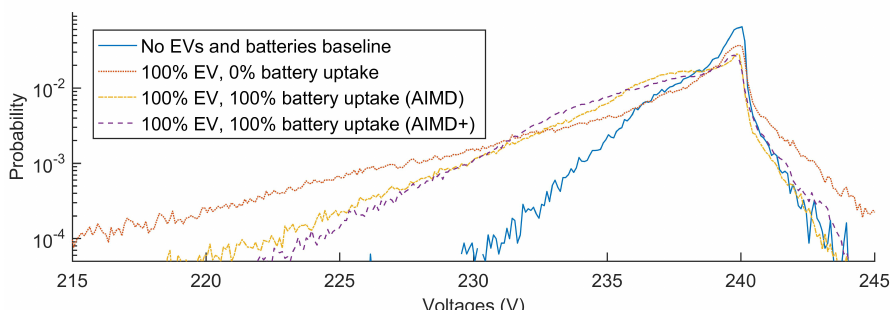
Figure 7. Voltage probability distribution of all loads’ buses for certain uptakes of EV and battery storage devices. Here, Case A is blue; Case B is red; Case C is yellow; and Case D is violet; with = − 0.153 and ζ ∗ = − 0.135. ζ ∗ D C